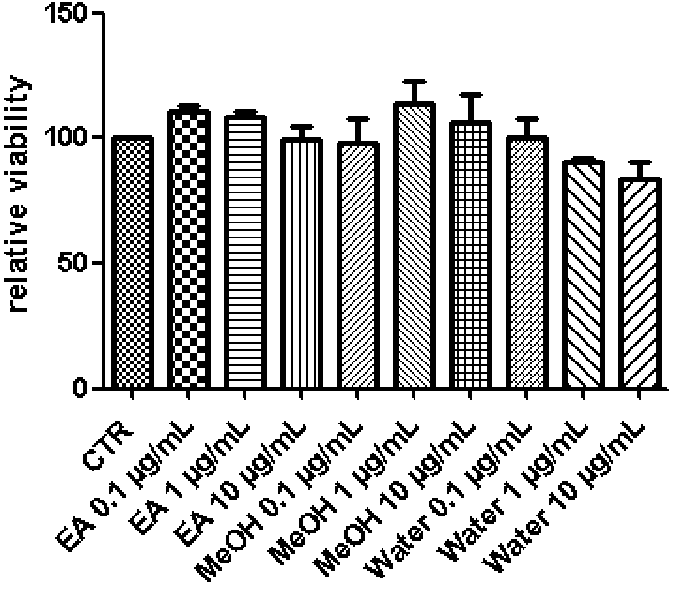
Figure 2. E ff ects of P. africanum water, methanol (MeOH), and ethylacetate (EA) extracts (0.1–10 µ g / mL) on hypothalamic HypoE22 cell line viability (MTT test), 24 h after